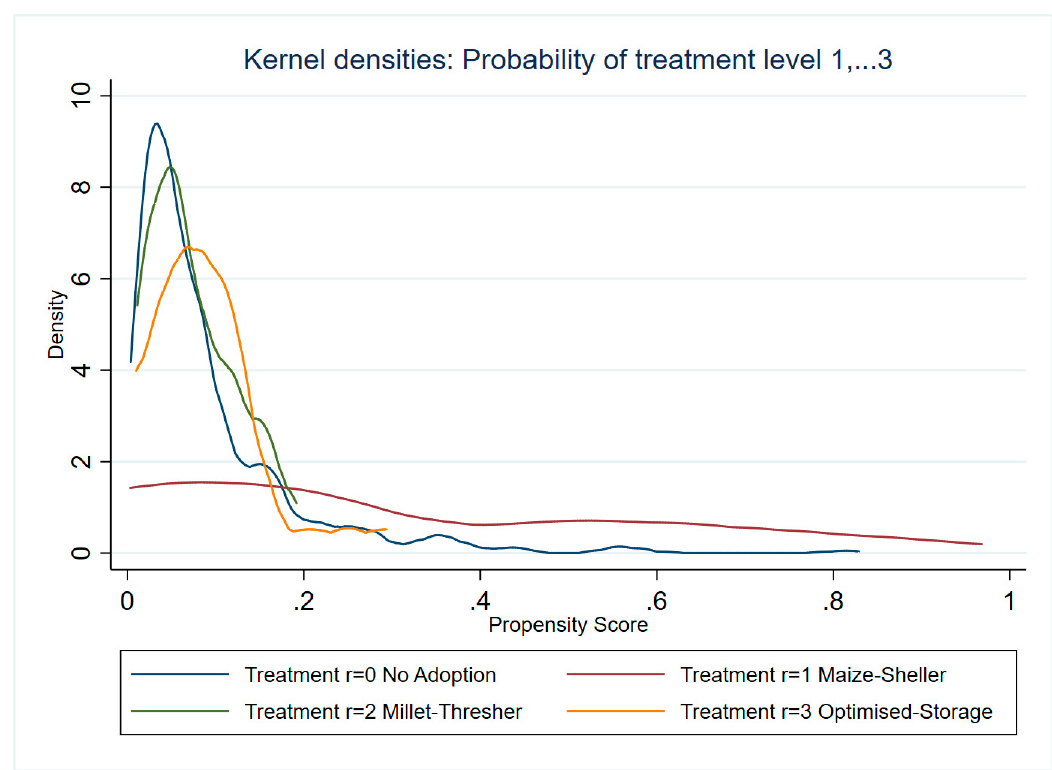
Figure A1. Kernel densities of the probability of treatment level r = 1, ... ,3. Note: Matching on Nearest Neighbour Matching (NNM) for upgrading strategies (UPS) [1,2,3] and binary case [0,1].